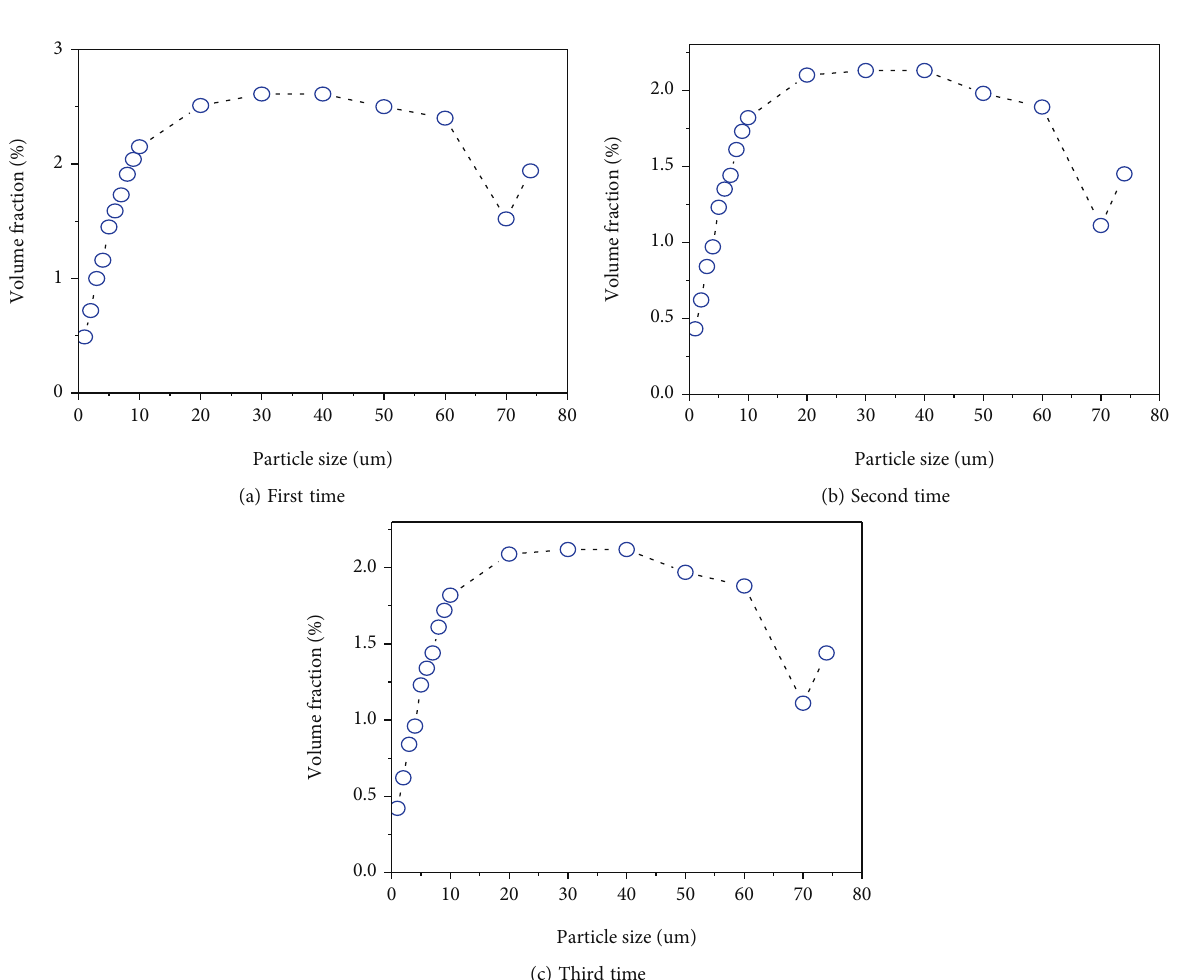
Figure 18: Volume fraction at di ff erent intervals compared with original sample under steel mesh.